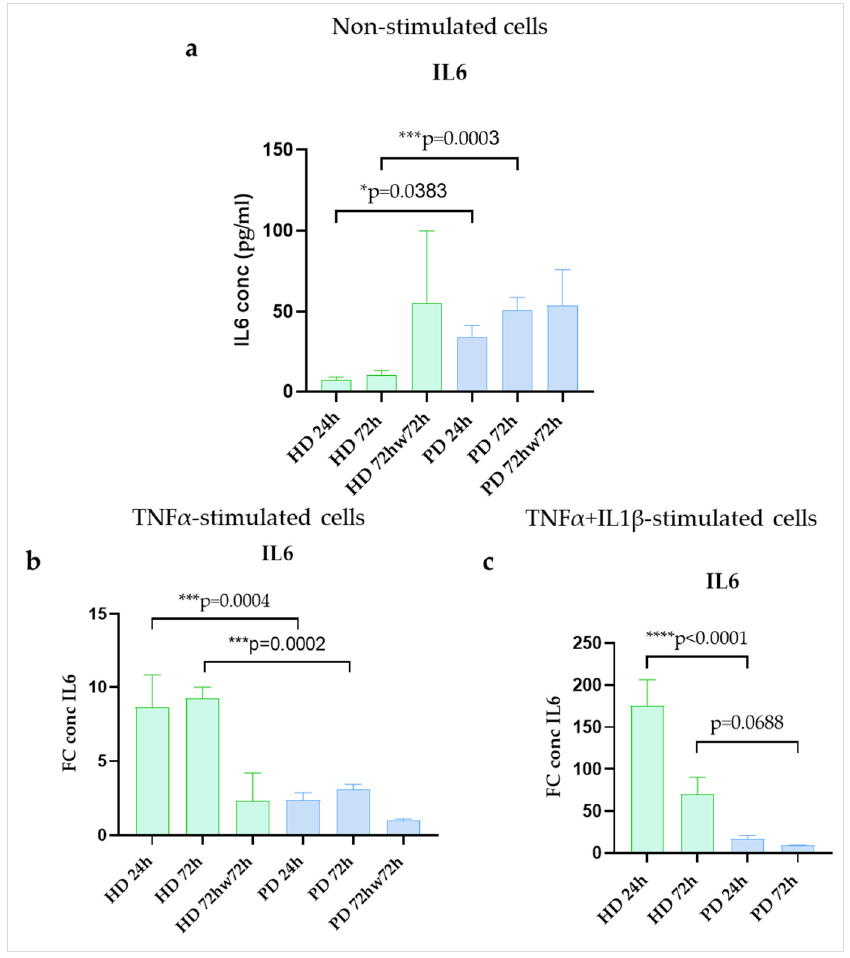
Figure 6. IL6 production in glial cultures derived from iPSCs of HD and patients with PARK2 -associated PD in steady state ( a ) and under inflammatory conditions ( b , c ). Green columns correspond to HD glial cultures, blue—to PD cultures. a. non-stimulated cells. Supernatants were collected at different time points of cultivation. IL6 concentrations were estimated using an ELISA assay (n = 3) and recalculated per 1 × 10 3 cells (pg/mL). The fold change (FC) of the IL6 concentration was calculated relative to mean value in non-stimulated cells at each time point. The data are shown as mean ± SEM. Two-way ANOVA with multiple comparisons corrected with Bonferroni test (for stimulated cells) were used for statistical processing. * p < 0.05, *** p < 0.0005, **** p < 0.0001.